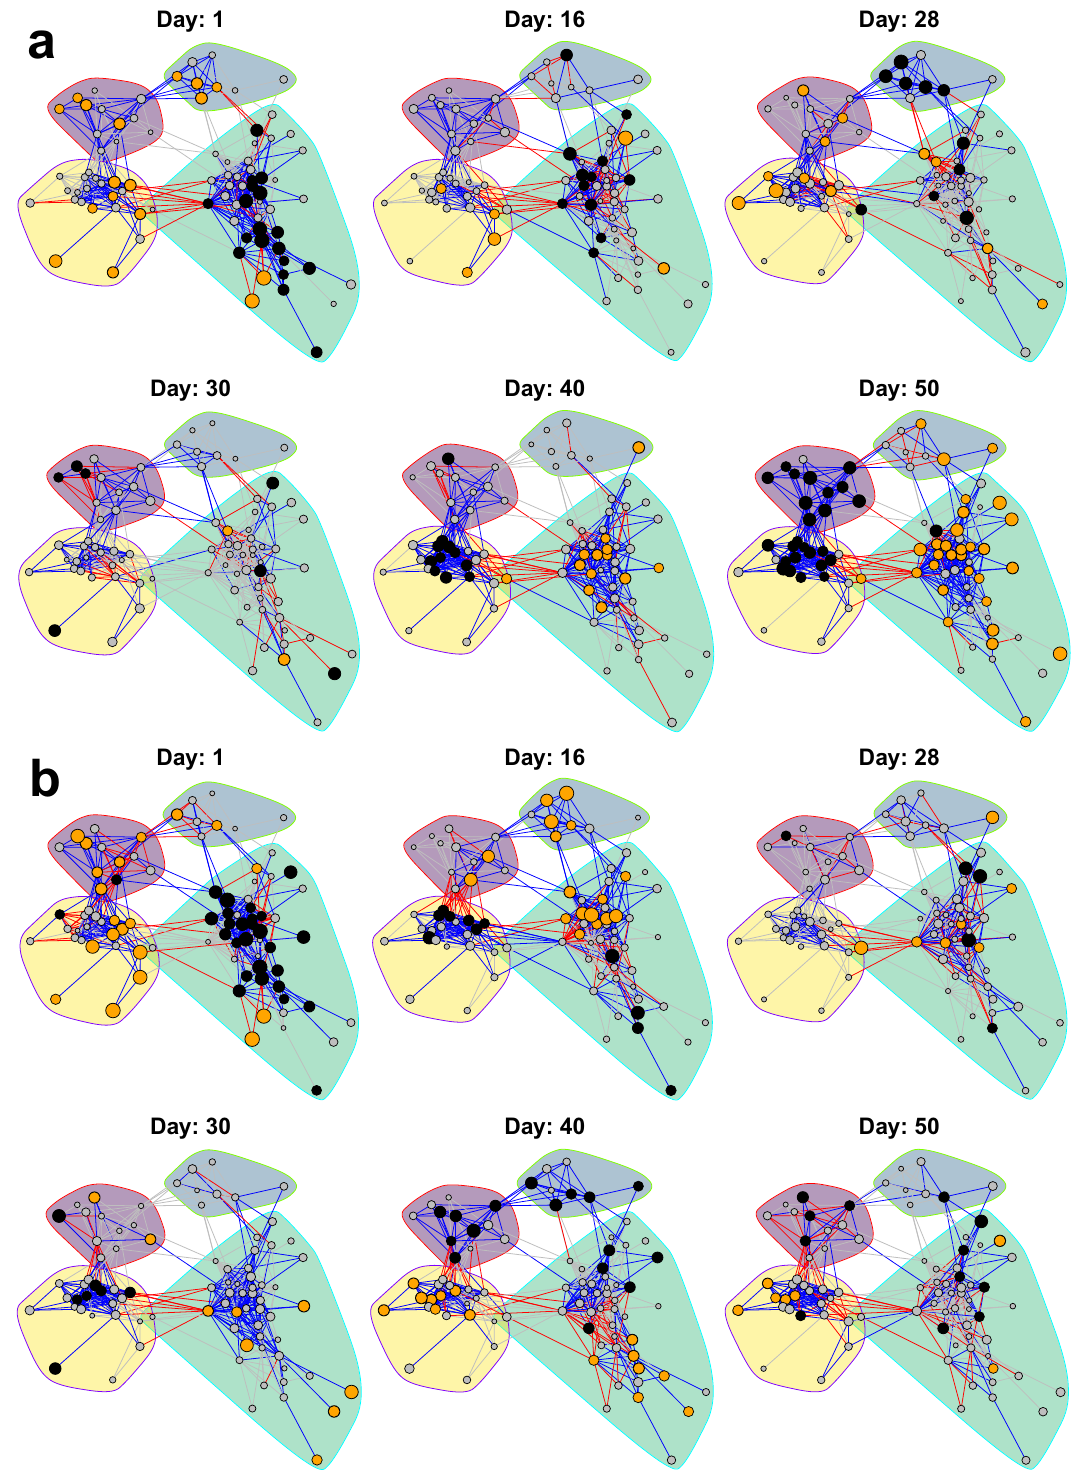
Figure 5. Dynamic visualisation of the network in Fig. 2, for ( a ) the RK selection group and ( b ) the KR selection group for high (H) resource supply. Nodes are coloured according to the corresponding OTUs’ abundance compared to its overall mean for all sampling days, represented by its z -score. Orange, grey and black nodes mean higher, about the same or lower abundance than its mean, respectively. The edges are coloured by the product of the nodes’ z -scores. This means that blue and red edges contribute to positive and negative association across the time series, respectively. The grey edges indicate that no major contribution to neither positive nor negative association is made. As we want to emphasize the orange and black nodes, the nodes with higher absolute z -scores are